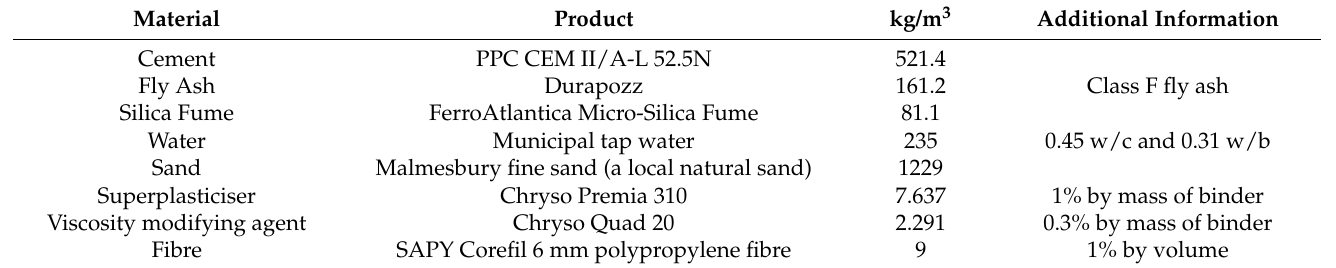
Table 2. 3DCP mix design.